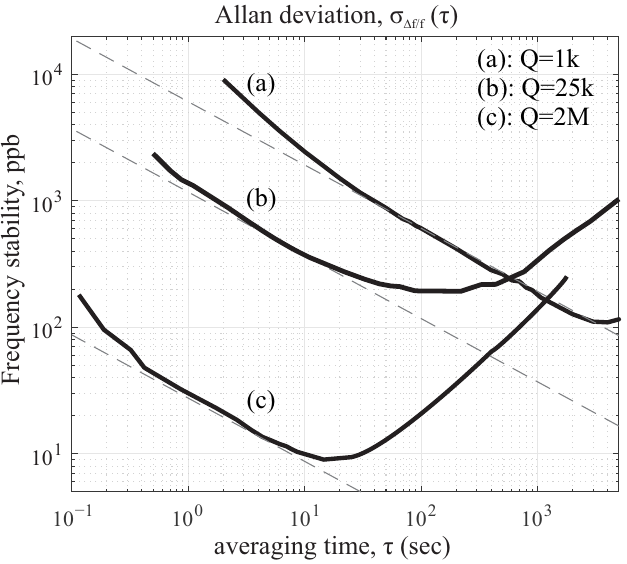
Figure 22. Characterization of the drive mode resonance frequency instabilities for three different Q-factors. The frequency white noise improved as the Q-factor